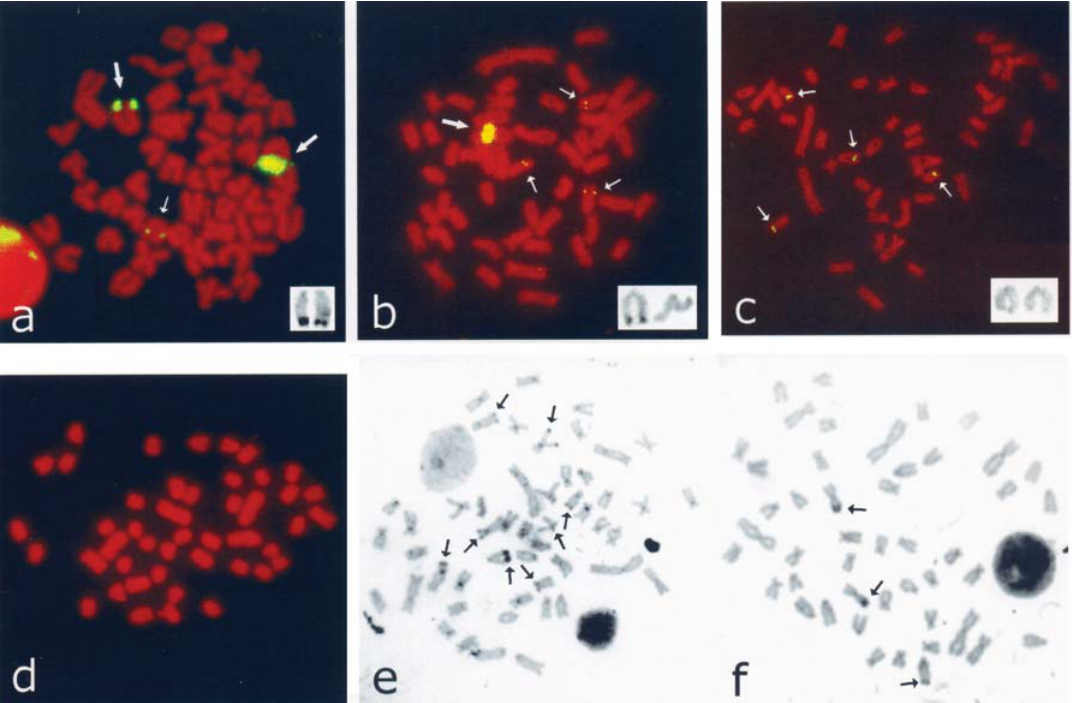
Figure 2 - Chromosomal distribution of FISH signals of As51 satellite DNA in three A. scabripinnis individuals from the Viveiro de Mudas stream (a, b and c). Large arrows indicate terminal blocks and small arrows indicate small subterminal signals. The acrocentric chromosomes bearing C-band distal blocks are shown in the inserts. No As51-FISH signals were observed on the chromosomes of A. scabripinnis from the Curral das Éguas stream (d). C-bandedmetaphasesfrom A.scabripinnis specimenscollectedintheViveirodeMudas(e)andCurraldasÉguas(f)streams(someC-bandsareindicated by arrows).